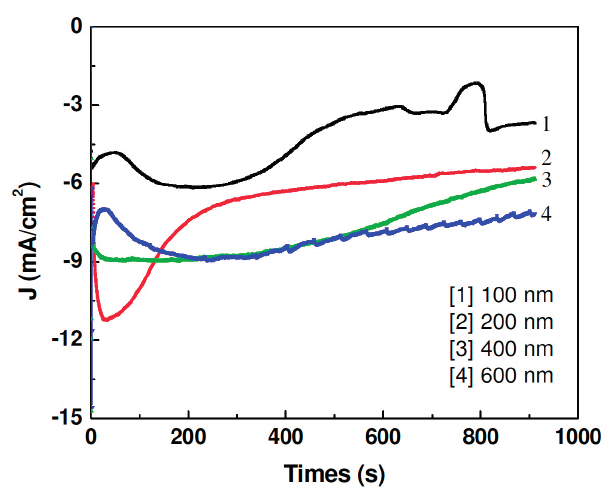
Figure 1. Current density versus time plots of CoNiP electrodeposited solution at a constant potential of − 0.9 V. In this plot, 100 nm, 200 nm, 400 nm, and 600 nm correspond to the diameters of the nanowires.